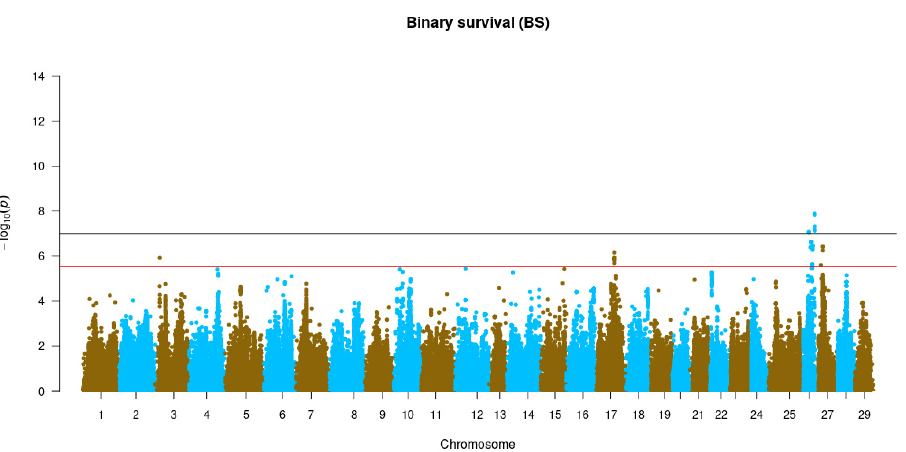
Figure 3. Genome-wide association analysis for resistance to P. salmonis in rainbow trout ( O. mykiss ) using WGS-imputed data. The black and red lines represent the genome-wide and chromosome-wide significance thresholds, respectively.